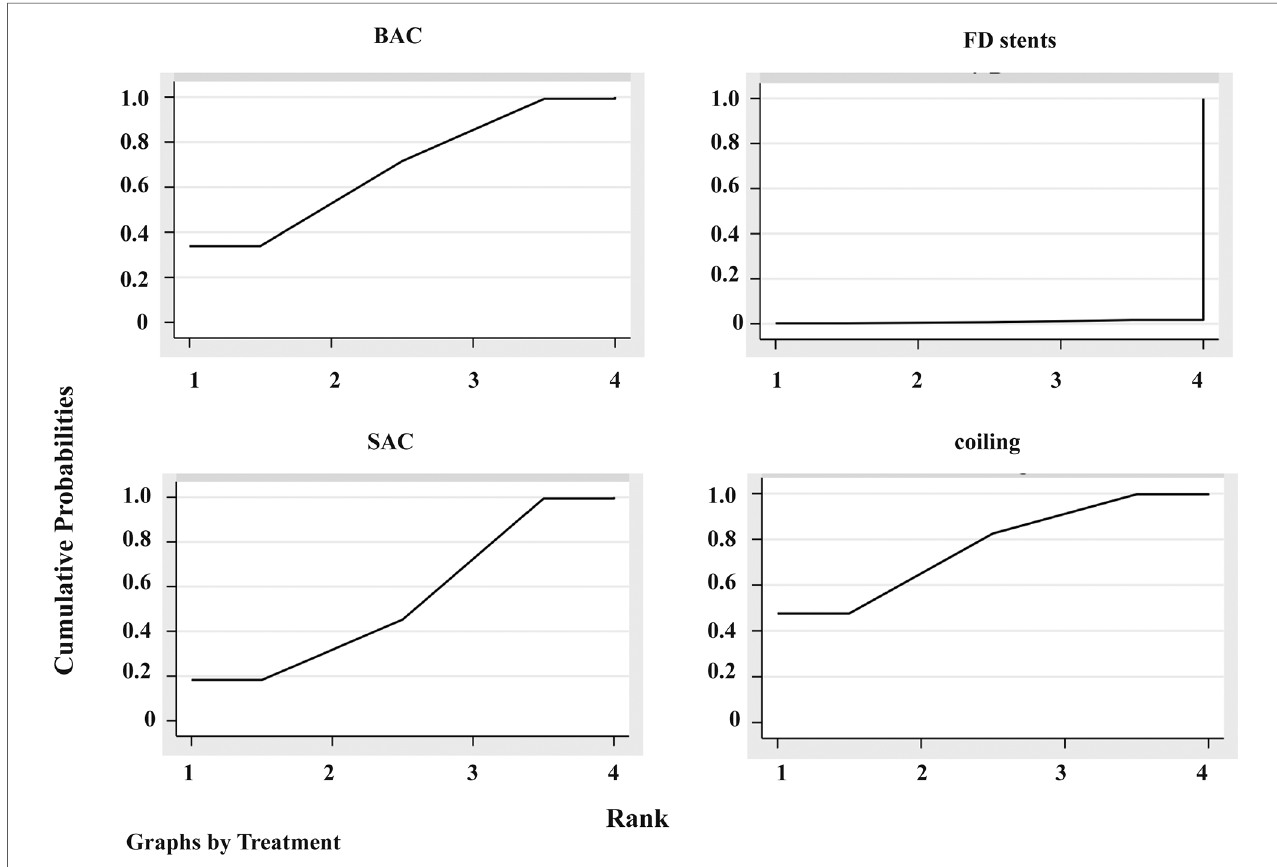
FIGURE 4 Plot of the surface under the cumulative ranking curves (SUCRA). BAC, balloon-assistant coiling; SAC, stent-assistant coiling; FD stents, fl ow-diverting